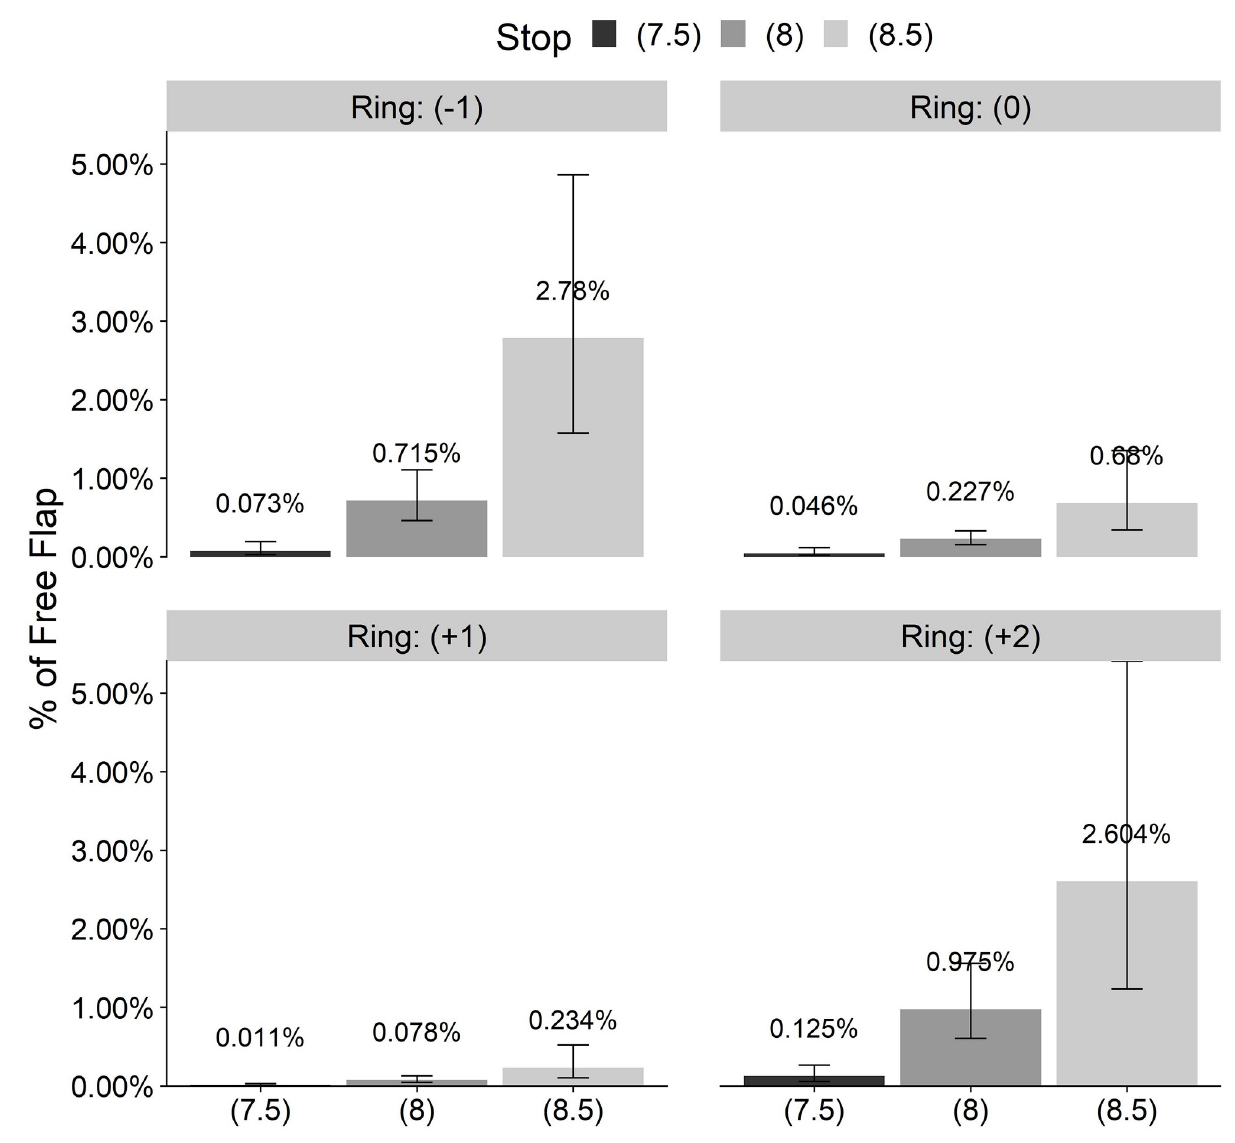
Fig 6. Predicted incidence of free flap by ring and